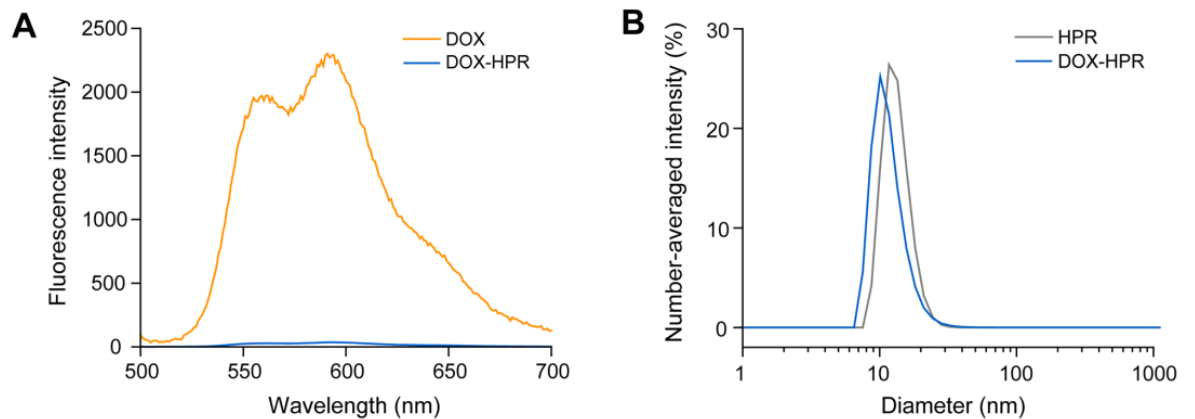
Figure 4. ( A ) Fluorescence spectra of DOX (1 μM) and DOX-HPR (1 μM DOX) in PBS. ( B ) Number- averaged size distribution of HPR (3 mg/mL) and DOX-HPR (3 mg/mL) in PBS.